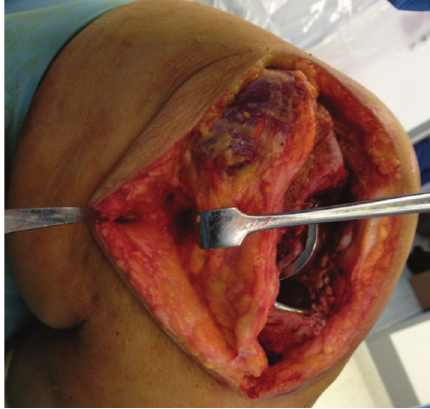
Intraoperative image showing raised medial skin flap Fig. 3: and site of posteromedial